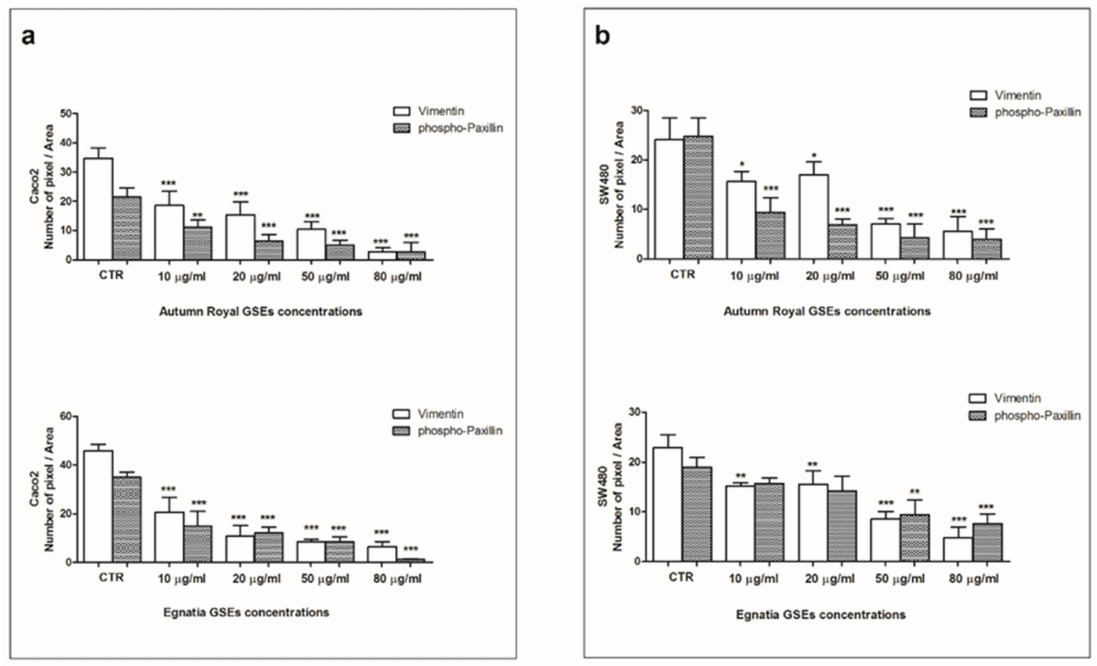
Figure 7. ( a ) Mean intensity index of Vimentin and Phospho-paxillin in fixed Caco2 cell lines treated with increasing concentrations of Autumn Royal and Egnatia GSEs (10, 20, 50, and 80 µ g / mL) for 48 h; ( b ) Mean intensity index of Vimentin and Phospho-paxillin in fixed SW480 cell lines treated with increasing concentrations of Autumn Royal and Egnatia GSEs (10, 20, 50, and 80 µ g / mL) for 48 h. Immudensitometry calculated by mean intensity index (Number of pixel / Area) of the Vimentin and phospho-Paxillin proteins detected using, randomly, five di ff erent areas from the single wall for each single independent experiment performed in triplicate. p -value was determined by ANOVA with Dunnett’s post-test. * p < 0.05, ** p < 0.03 and *** p < 0.01 versus control group